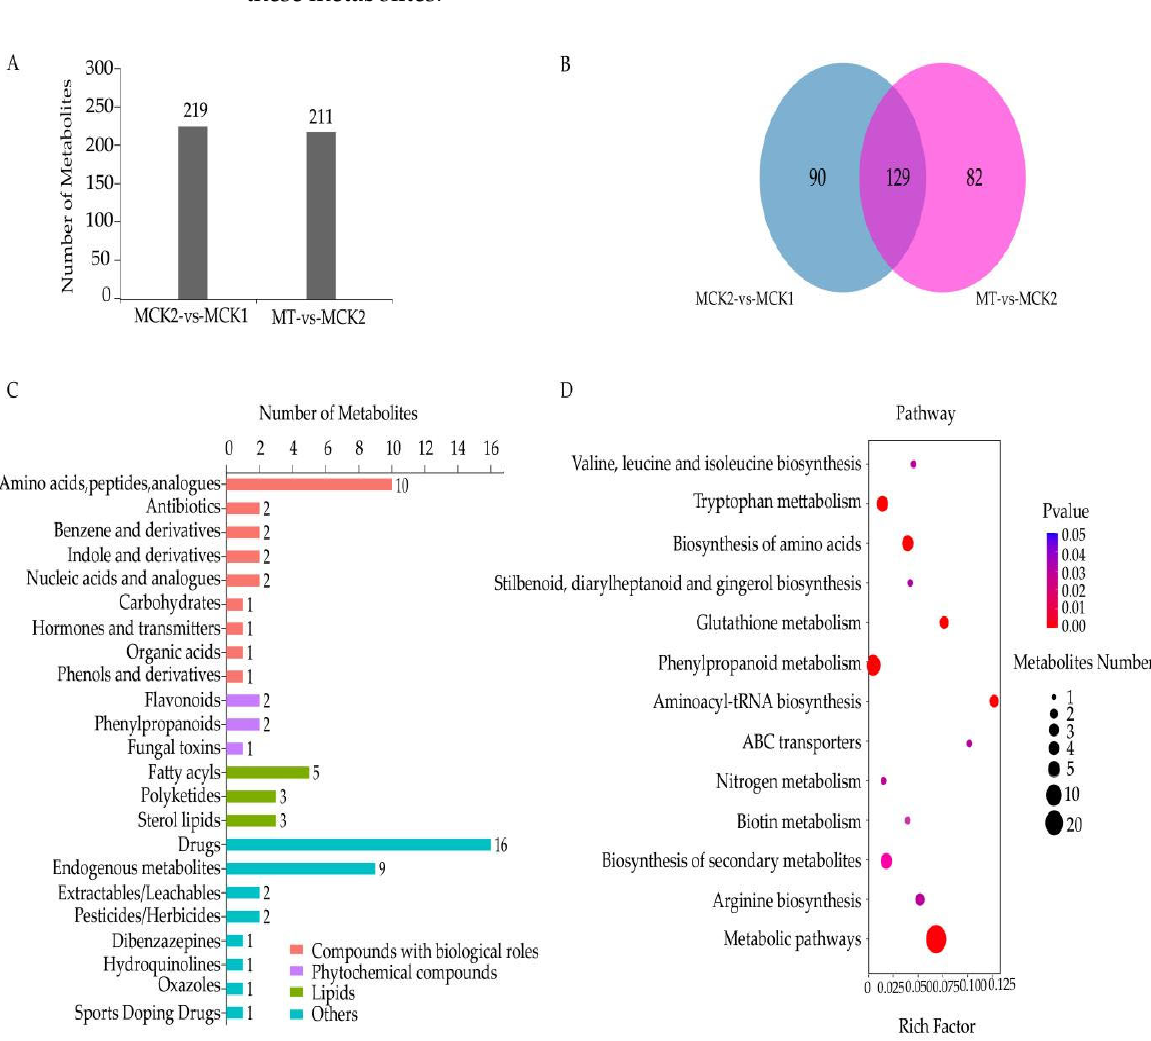
Figure 9. Statistics for DEMs. ( A ) The number of DEMs in the root. ( B ) Venn diagrams of DEMs in the comparison groups in the root. ( C ) KEGG categories of DEMs. ( D ) KEGG pathway enrichment analysis of DEMs. MCK1 represents metabolites of watermelon seedlings cultured in normal Hoagland solution; MCK2 represents metabolites of watermelon seedlings cultured in Hoagland solution containing 150 mm NaCl, and MT represents metabolites of watermelon seedlings cultured in Hoagland solution containing 150 mM NaCl and 20 mM trehalose.